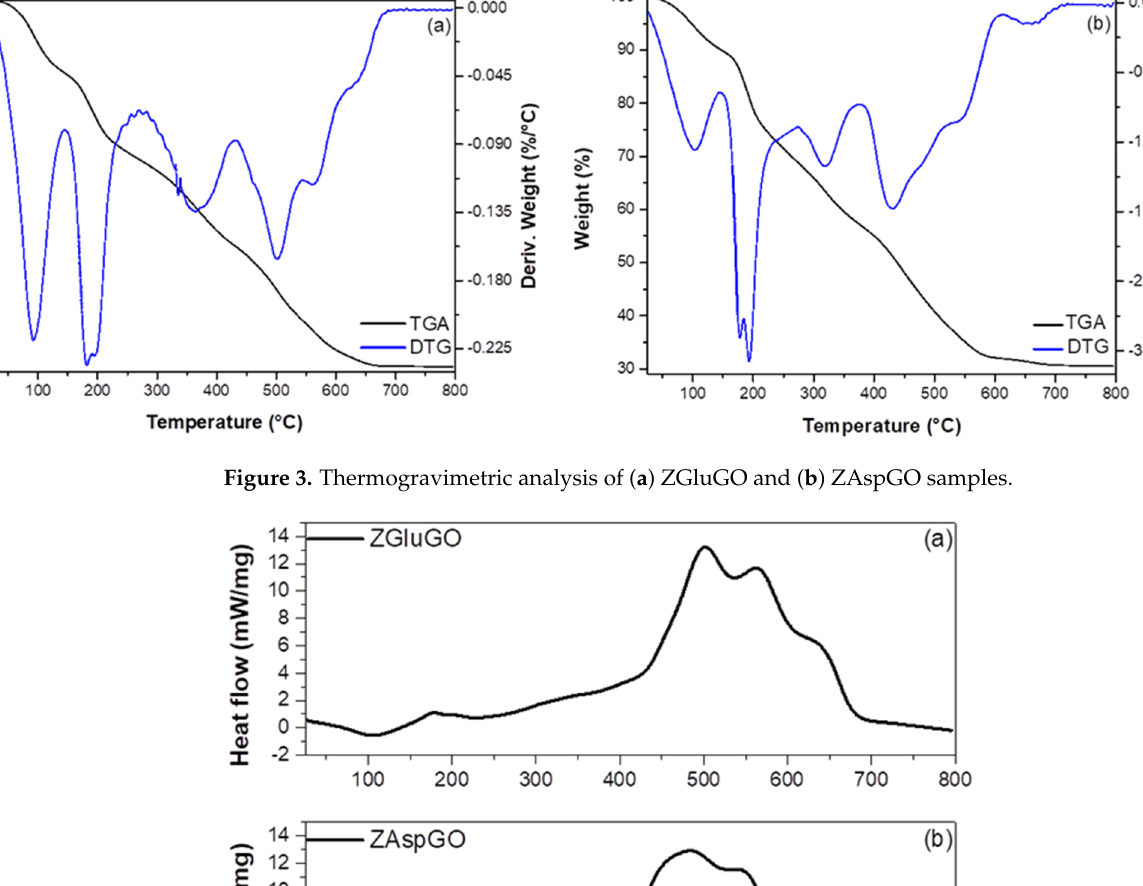
Figure 4. The differential scanning calorimetry plots of ( a ) ZgluGO and ( b ) ZaspGO samples. The FTIR spectra were measured for the amino acids aspartic acid and glutamic acid, and the adsorbent materials ZgluGO and ZAspGO, before and after adsorbing the fluo- ride ion (Figure 5). The spectra obtained for the amino acids concur with the signals re- ported in the literature [48,49].